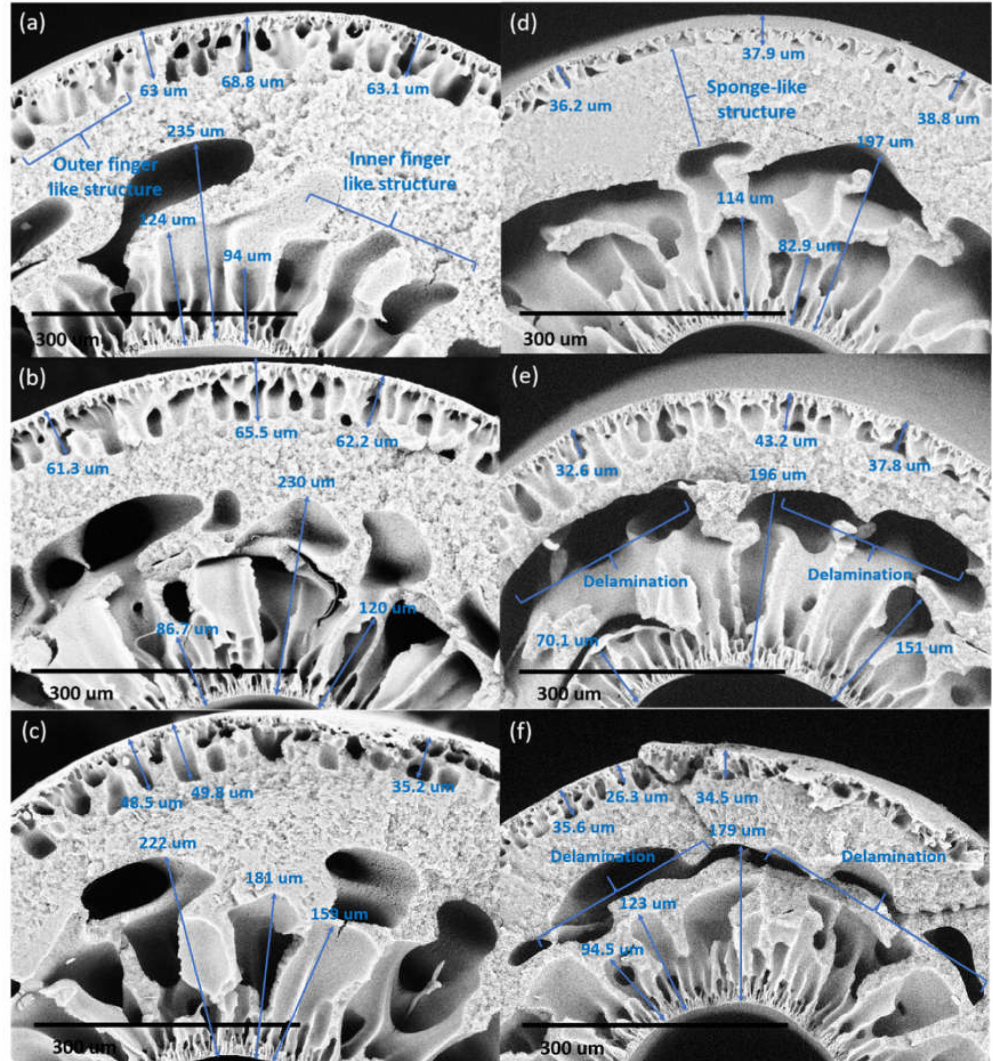
Figure 6. The cross-section ( × 300 magnification) structure of DL-ZT0 membranes spun at di ff erent air gap of ( a ) 5 cm, ( b ) 10 cm, ( c ) 20 cm, ( d ) 30 cm, ( e ) 40 cm, and ( f ) 50